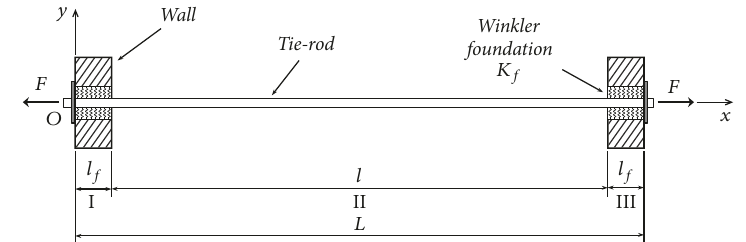
Figure 2: Tie-rod with elastic bed-type